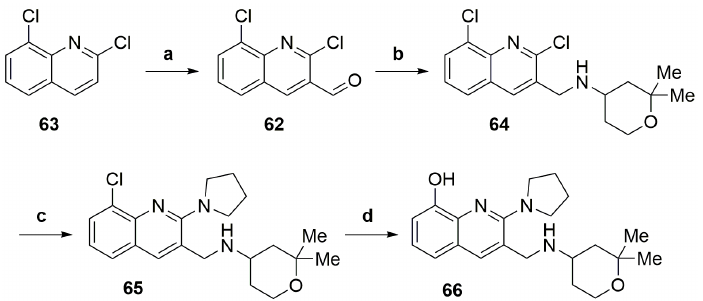
Figure 4 - Synthesis of 8-chloro and 8-hydroxy analogues. Reagents and conditions: a ) LDA (Lithium diisopropylamide), THF, DMF, -78°C, 39%; b ) 2,2-dimethyltetrahydro-2H-pyran-4- amine, NaBH(OAc) , DCE (1,2-dichloroethane), 47%; c ) pyrrolidine, NaOtBu, dioxane, 80°C, 3 38%; d ) Pd (dba) , NaOtBu, NaOH 10%, t Bu Brett Phos [2-(Di- tert -butylphosphino)-2′,4′,6′- 2 3 aq triisopropyl-3,6-dimethoxy-1,1′-biphenyl] , 1,4-dioxane, 100°C,